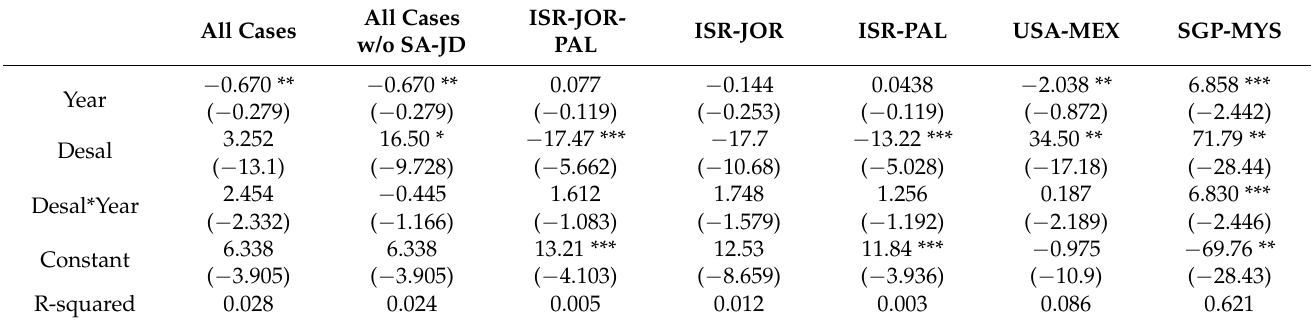
Table 5. Regressions using the All Years dataset.